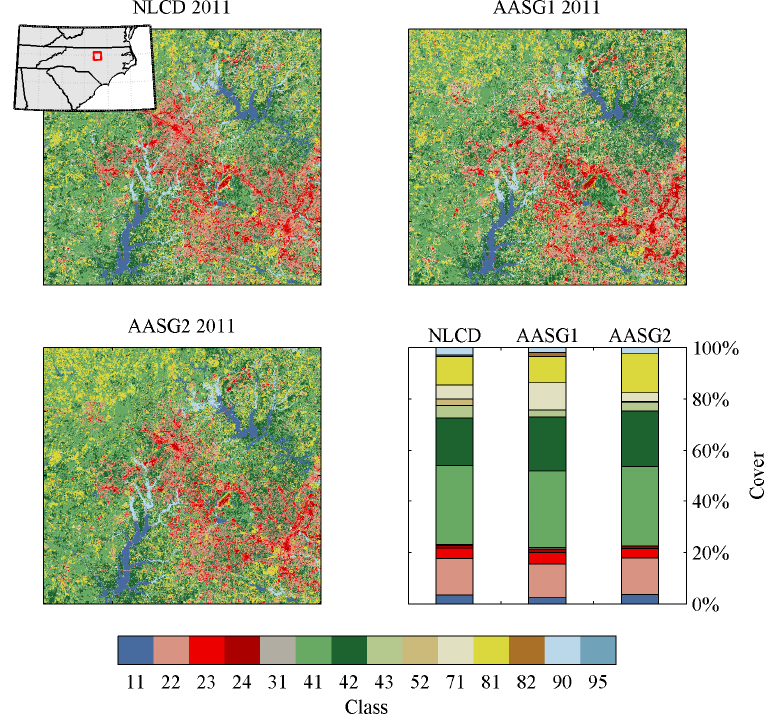
Figure 5. 2011 land cover from NLCD, AASG1, and AASG2.